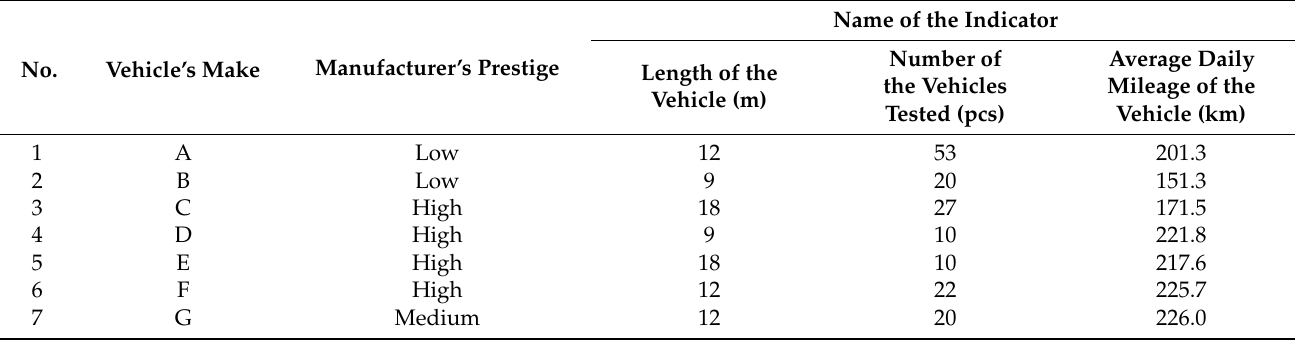
Table 1. Characteristics of the studied bus sample during 12 years of